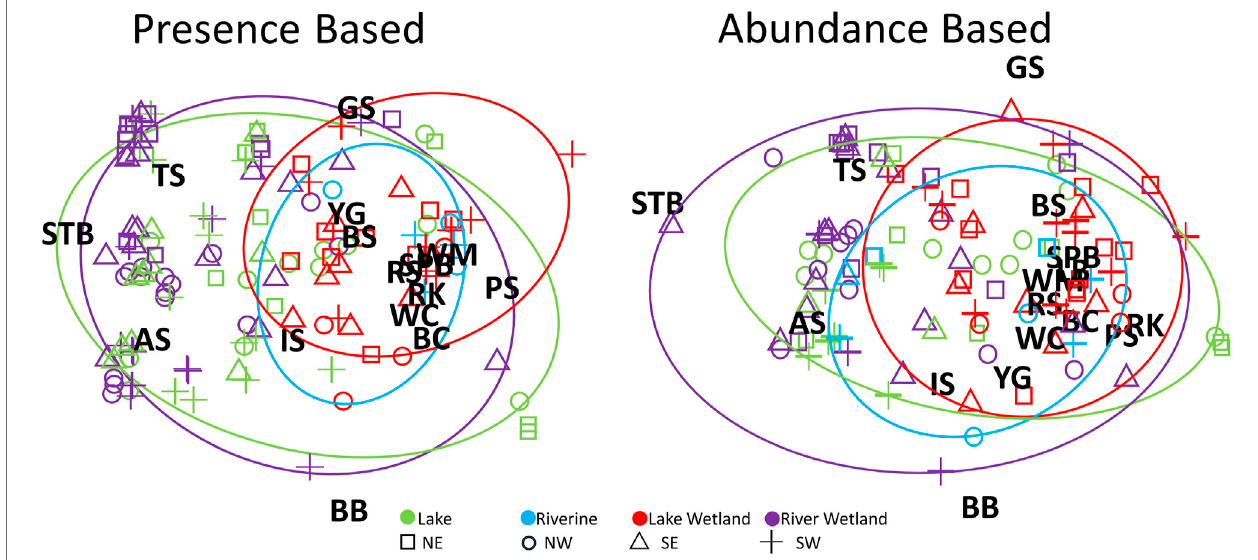
FIGURE 5 | Non-metric Multidimensional Scaling plots for the presence-based (left; stress: 0.085) and abundance-based (right; stress: 0.128) community composition data. Colors and shapes of points match the Principal Components Analysis plot ( Figure 3 ), as do the colors of the ellipses, which are drawn to enclose all observations withinthe habitat types. Thetwoaxes ineach plotareon thesame scale, allowing plottinginspacewithoutaxis lines.Ovalsizeindicatesrelativenumberof species observed. Species are: American Shad (AS), Black Crappie (BC), Bluegill Sun fi sh (BS), Brown Bullhead (BB), Golden Shiner (GS), Inland Silverside (IS), LargemouthBass(LB),PricklySculpin(PS),RainwaterKilli fi sh(RK),RedearSun fi sh(RS),SpottedBass(SPB),StripedBass(STB),Thread fi nShad(TS),Warmouth(WM), White Cat fi sh (WC), Shimofuri Gobi (SG).